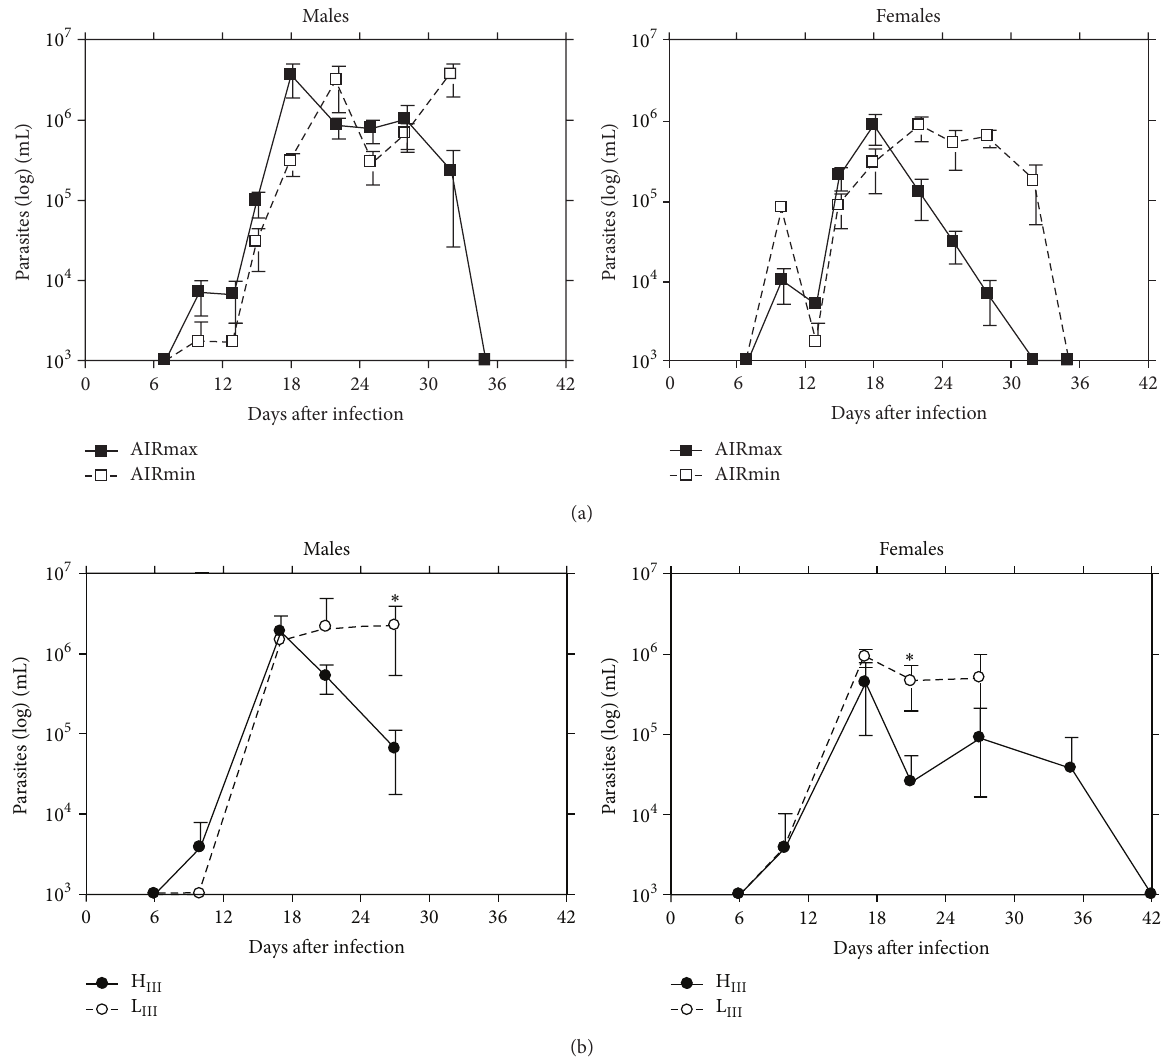
Figure 3: Parasitemia of (a) AIRmax, AIRmin mice ( 𝑛 = 6 animals/group), and (b) H III , L III mice ( 𝑛 = 4 animals/group) during the acute phase of infection with 10 2 trypomastigote forms of T. cruzi (CL strain). The results are expressed as the mean ± SE of each group of males and females and significant differences between AIRmax versus AIRmin and between H III versus L III mouse lines in parasitemia levels are indicated: ∗ 𝑃 < 0.05